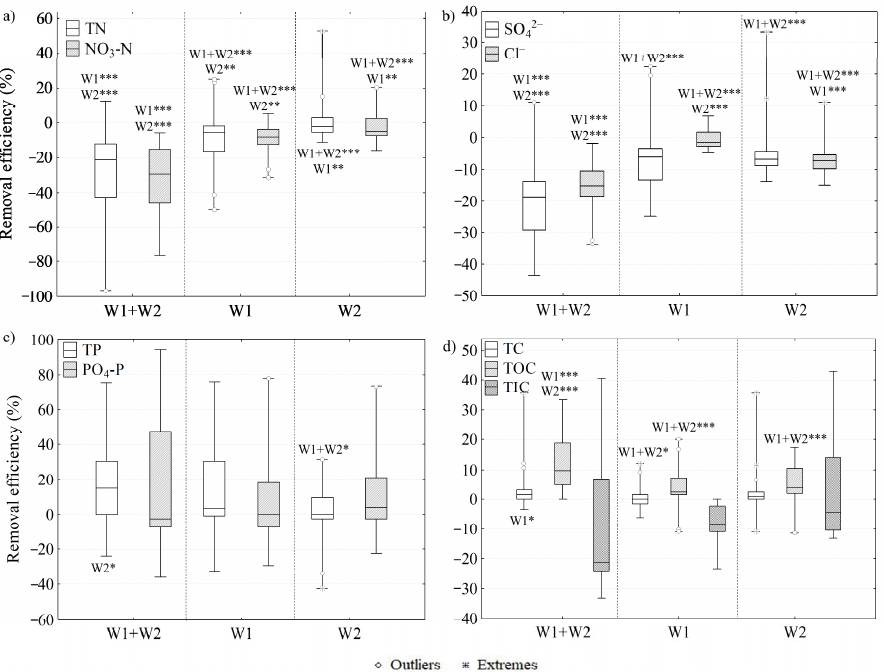
Figure 2. Removal efficiencies (%) of first wetland (W1), second wetland (W2) and their combination (W1 + W2) during the study period for ( a ) total nitrogen (TN), nitrate (NO 3 -N), ( b ) sulphate (SO 42 − ), chlorine (Cl − ), ( c ) phosphate (PO 4 -P), total phosphorus (TP) and ( d ) total carbon (TC), total organic carbon (TOC) and total inorganic carbon (TIC). Median, min/max, 25% and 75% quartile values are presented. Asterisks with numbers denote statistically significant differences between first wetland (W1), second wetland (W2) and their combination together (W1 + W2), according to the Mann-Whitney U test: *** p < 0.001, ** p < 0.01, * p <